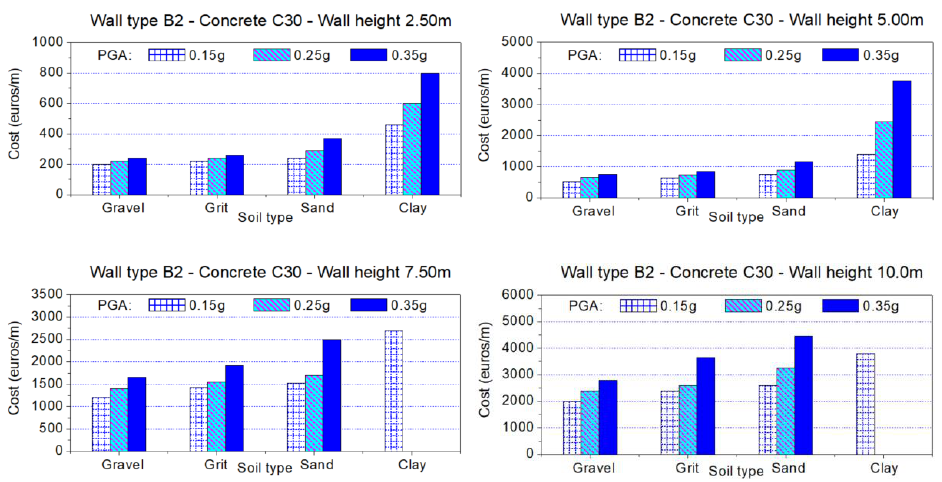
Figure 12. Cost of retaining walls type B2 made by reinforced concrete C30. Figure 11. Cost of retaining walls type B2 made by reinforced concrete